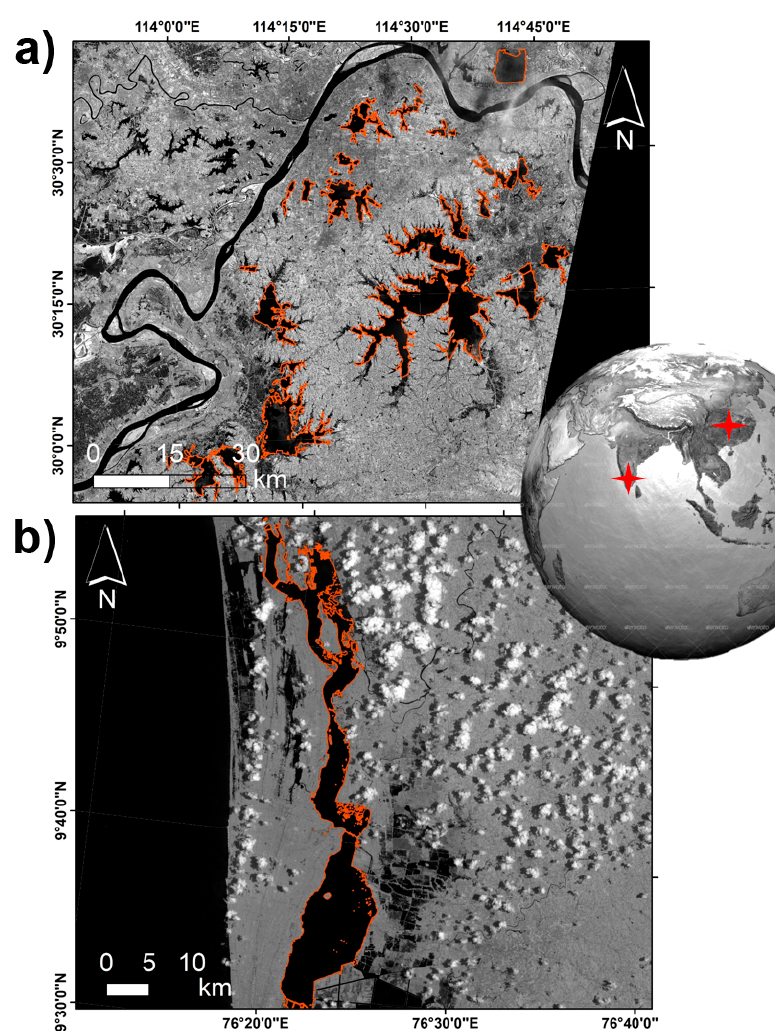
Figure 1. Location of the study area ( a ) lakes of Wuhan, China, and ( b ) Vembanad Lake, India.